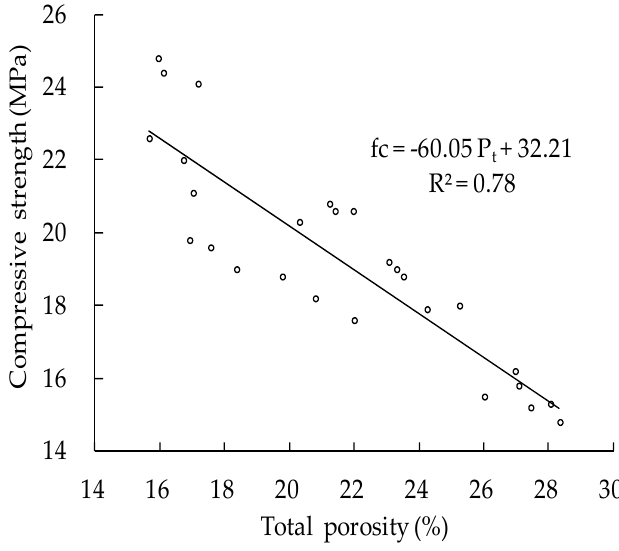
Figure 9. Relationship between compressive strength and total porosity.